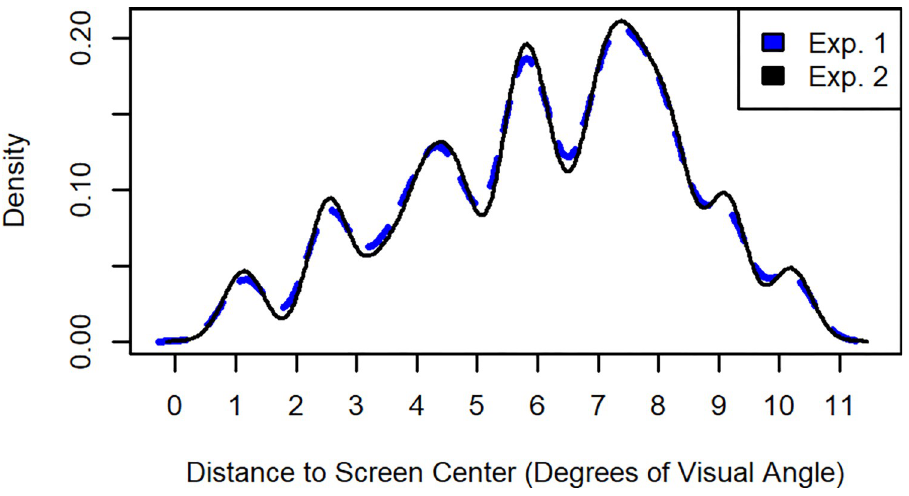
Fig 4. Density plot: Distance of probed object to the center of the screen (during encoding) in Experiments 1 and 2.